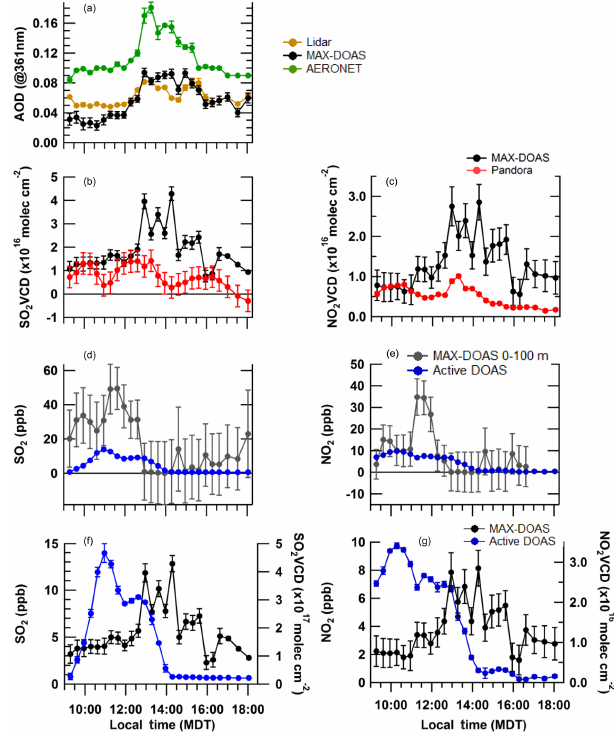
Figure 8. The 6 September AODs from MAX-DOAS, lidar, and AERONET (a) ; MAX-DOAS SO 2 VCDs (b) ; MAX-DOAS NO 2 VCDs (c) ; MAX-DOAS 0–100m and active DOAS SO 2 mixing ratios (d) ; MAX-DOAS 0–100m and active DOAS NO 2 mixing ratios (e) ; MAX-DOAS VCDs and active DOAS mixing ratios of SO 2 (f) ; and MAX-DOAS VCDs and active DOAS mixing ratios of NO 2 (g) . MAX-DOAS error bars were obtained from the optimal estimation retrieval. Error bars on the lidar and AERONET AODs are the standard error of the temporally averaged values. Error bars on the active DOAS mixing ratios are root-sum-square errors of the standard error from averaging and the DOASIS retrieval error. See Sect. 2.3.3 for details.